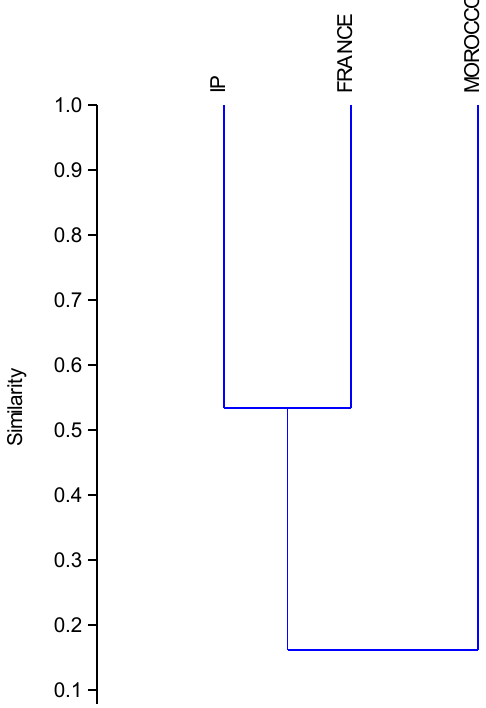
Figure 4. Cluster analysis based on the similarity (Jaccard’s Index) of the ant species found in the three adjacent areas (IP, France and